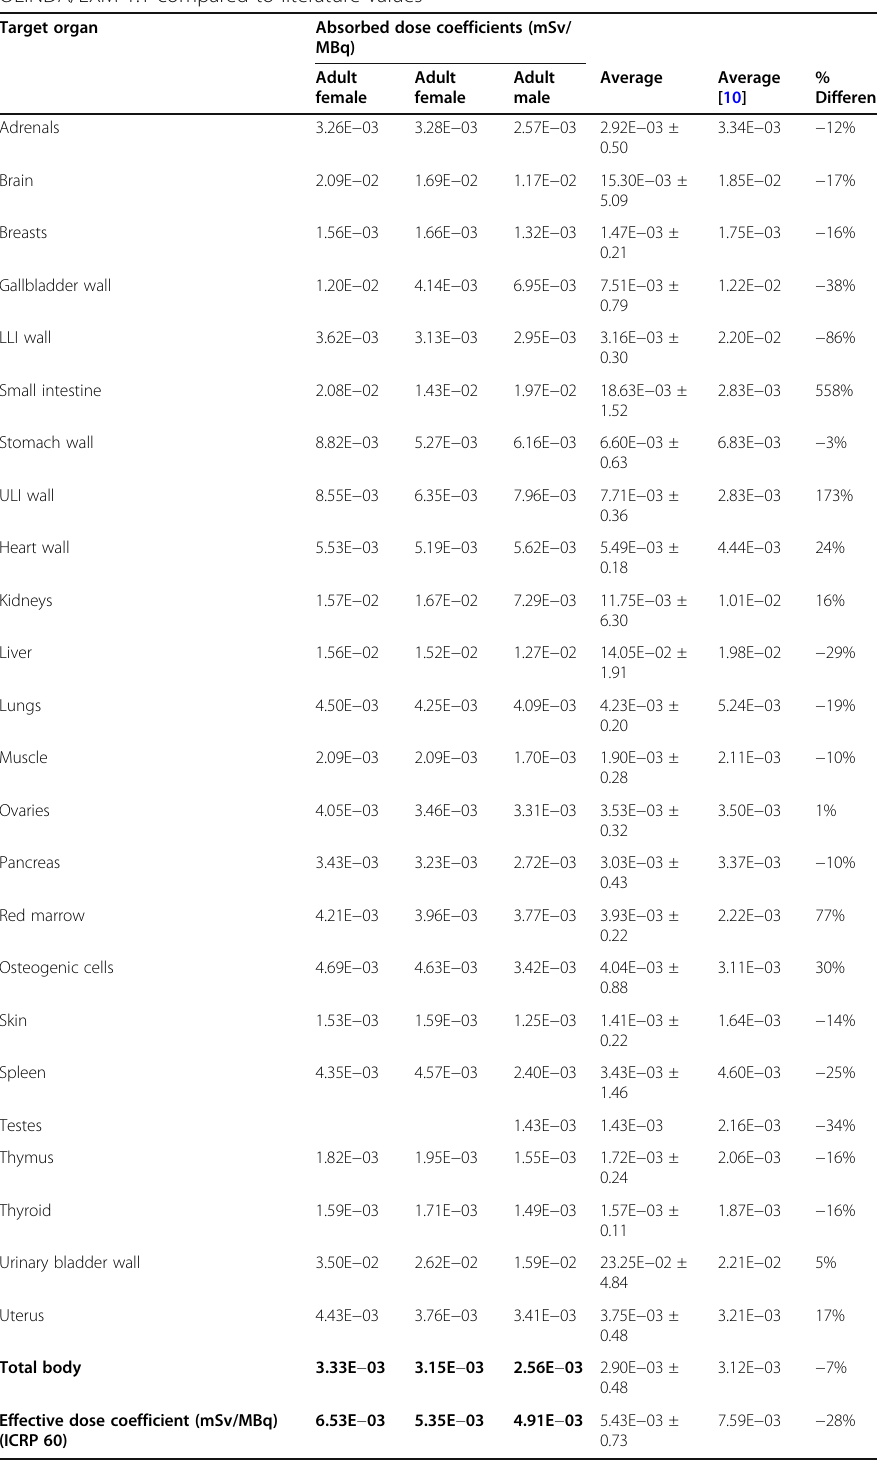
Table 3 Absorbed dose coefficients for [ 11 C]-UCB-J determined from three healthy subjects using OLINDA/EXM 1.1 compared to literature